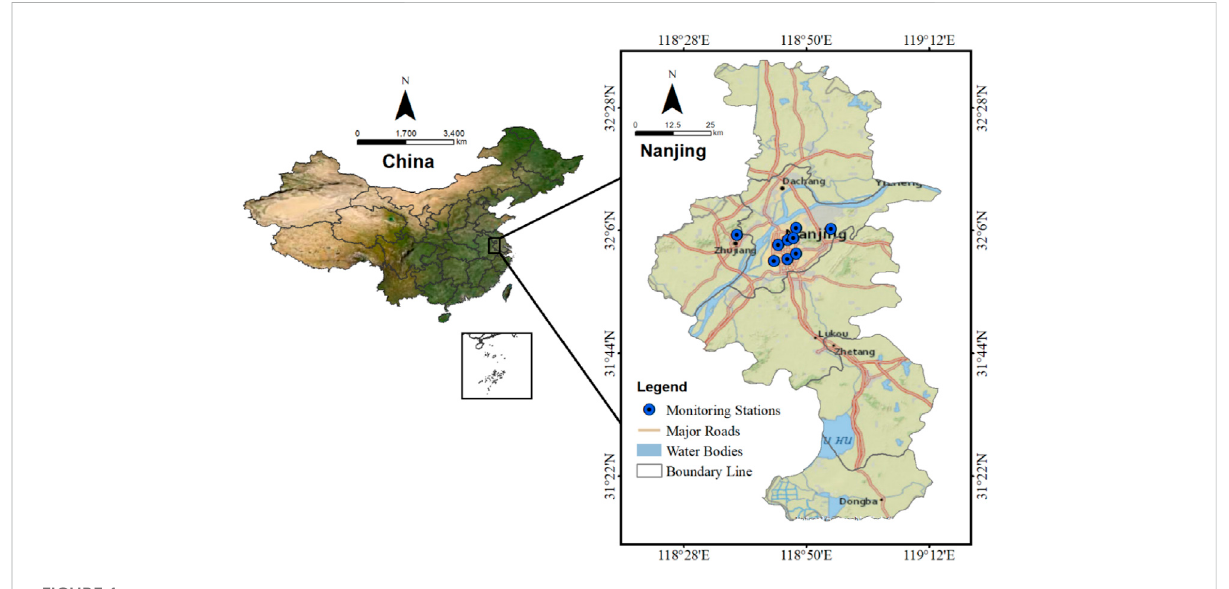
FIGURE 1 Geographical location and the air pollution monitoring sites in